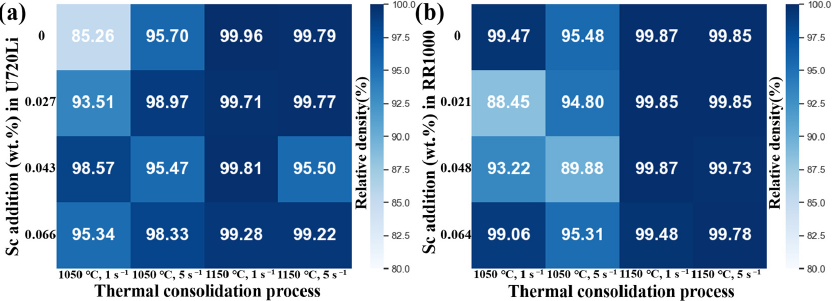
Figure 3. Relative density of superalloys with different scandium addition under different thermal consolidation processes: ( a ) U720Li, ( b ) RR1000. The hardness of U720Li and RR1000 with di ff erent addition of scandium under dif-